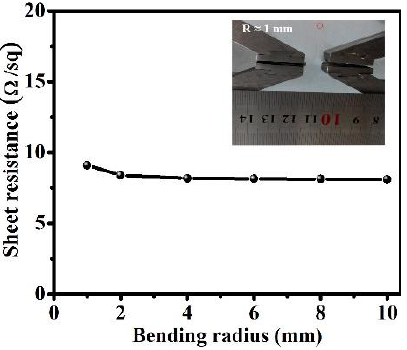
Figure 7. Sheet resistance of ZnO/Ag/ZnO multilayer films after 800 bending repetitions for different bending radii.